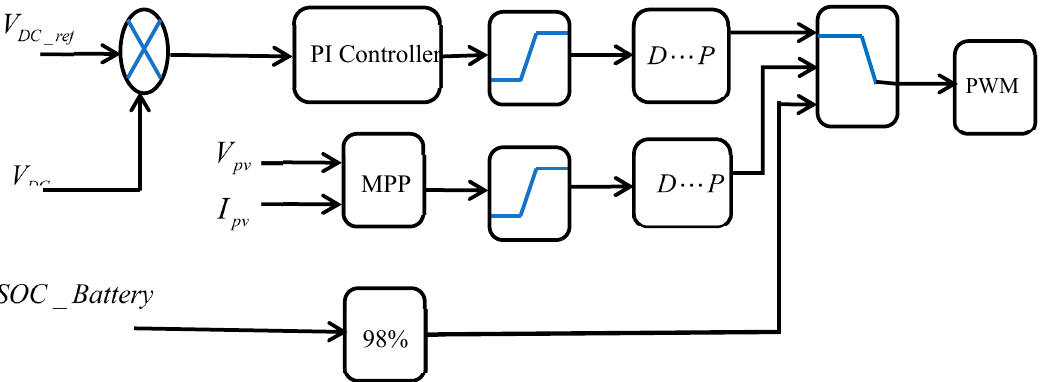
Figure 8. Schematic diagram of the proposed multi-loop proportional integral (PI) controller of V DC .